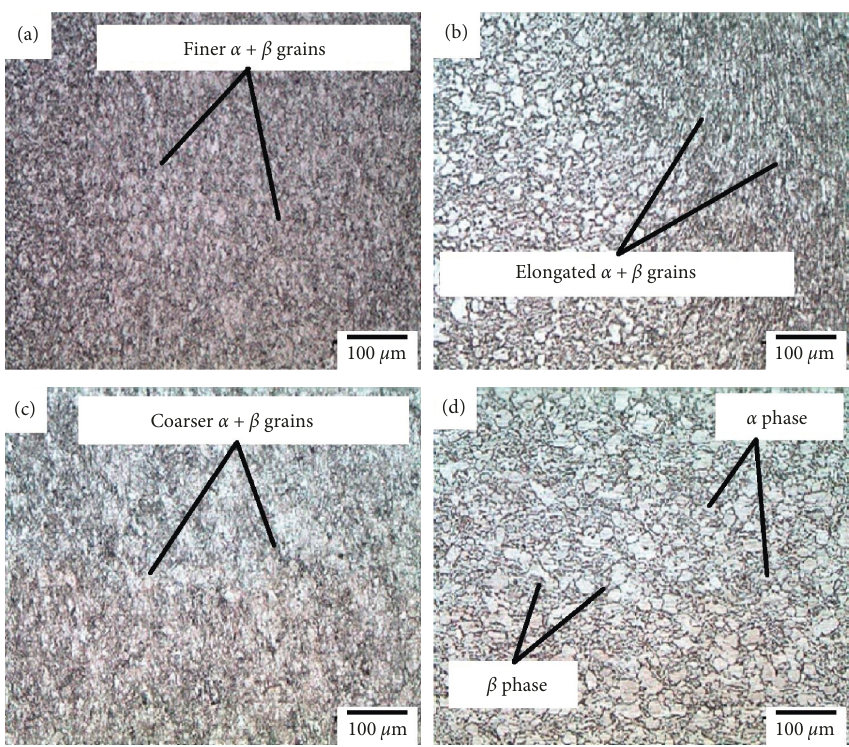
Figure 9: Optical micrograph of different regions of LFW-Ti6Al4V alloy joint: (a) weld interface; (b) TMAZ; (c) HAZ, and (d) unaffected parent